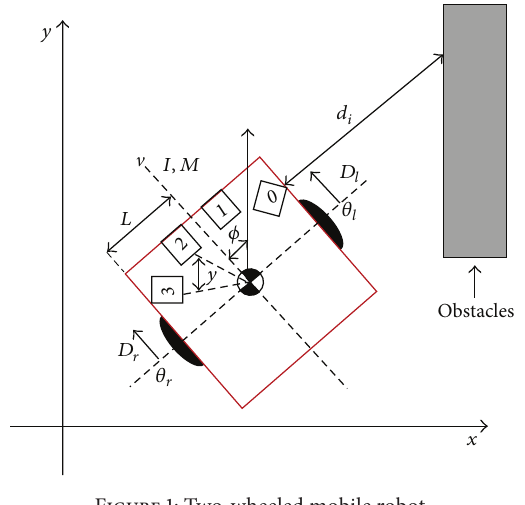
Figure 1: Two-wheeled mobile